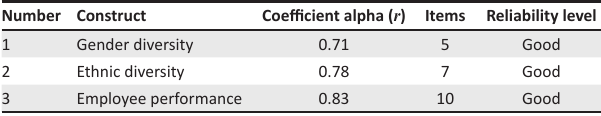
TABLE 2: Reliability of gender diversity, ethnic diversity and employee performance.